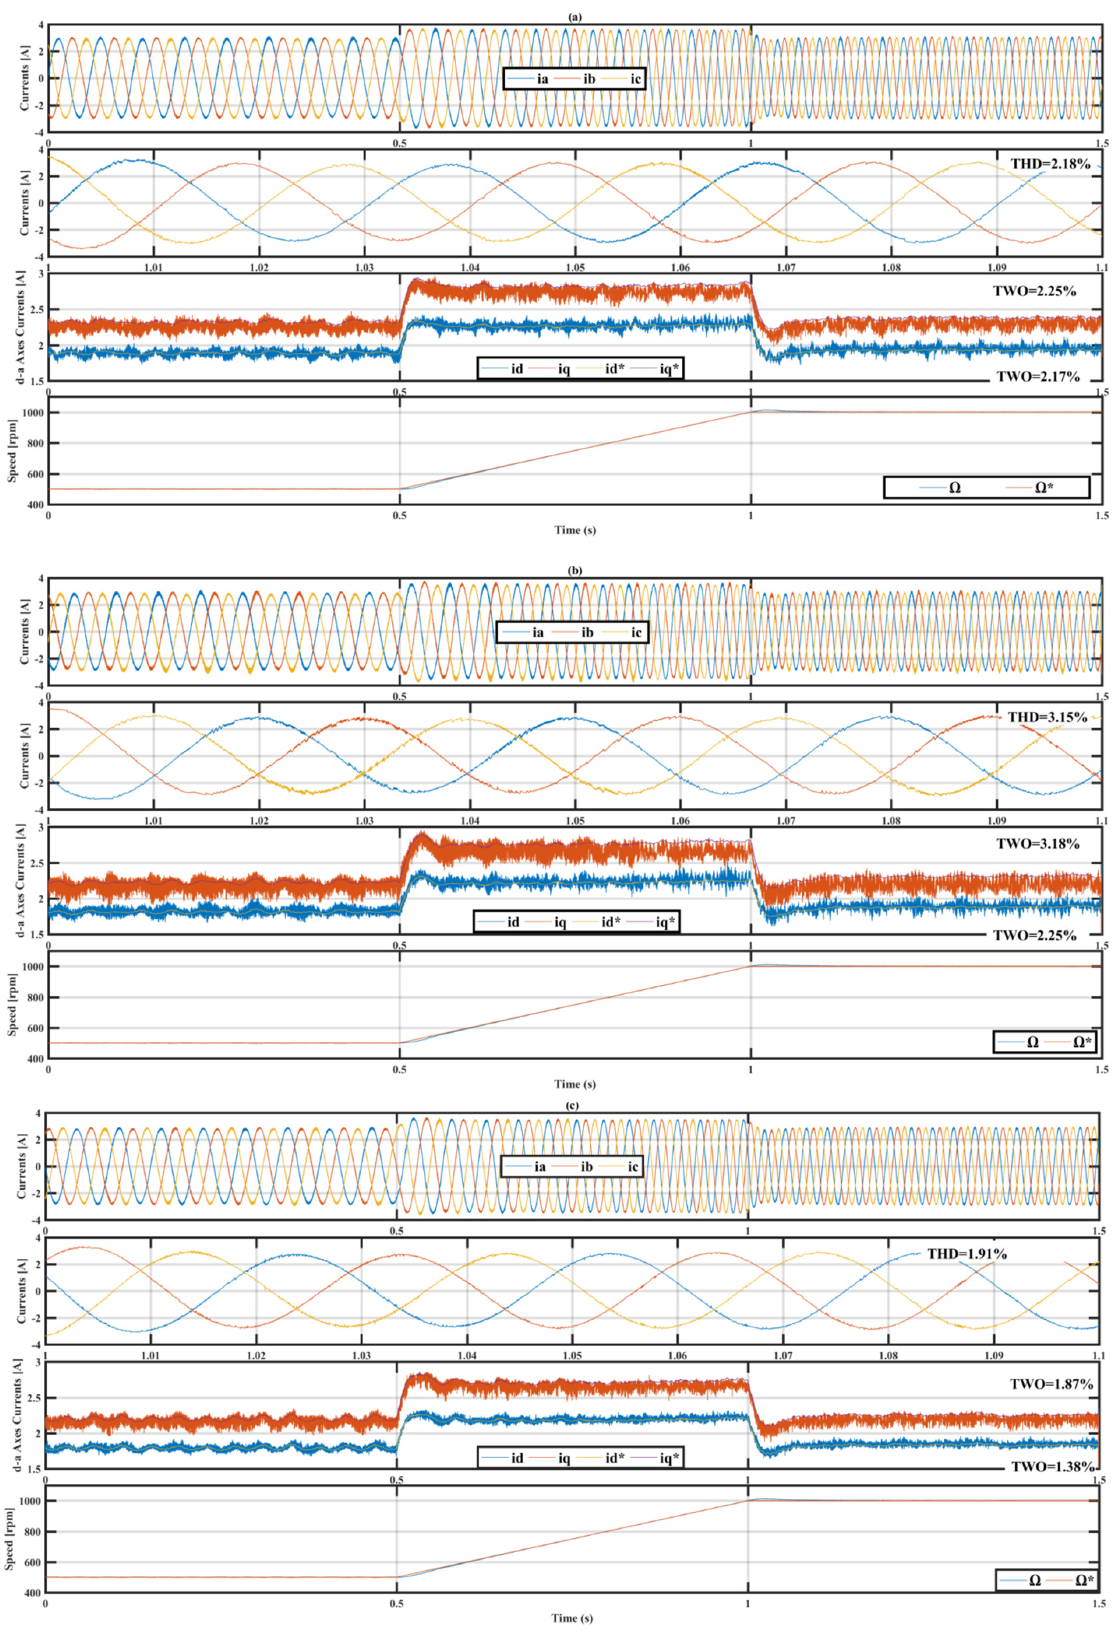
Figure 6. Experimental results of ( a ) MPCC (T s = 35 μ s), ( b ) HCC–MPCC (T s = 35 μ s) and ( c ) HCC–MPCC (T s = 28 μ s), under speed variations.